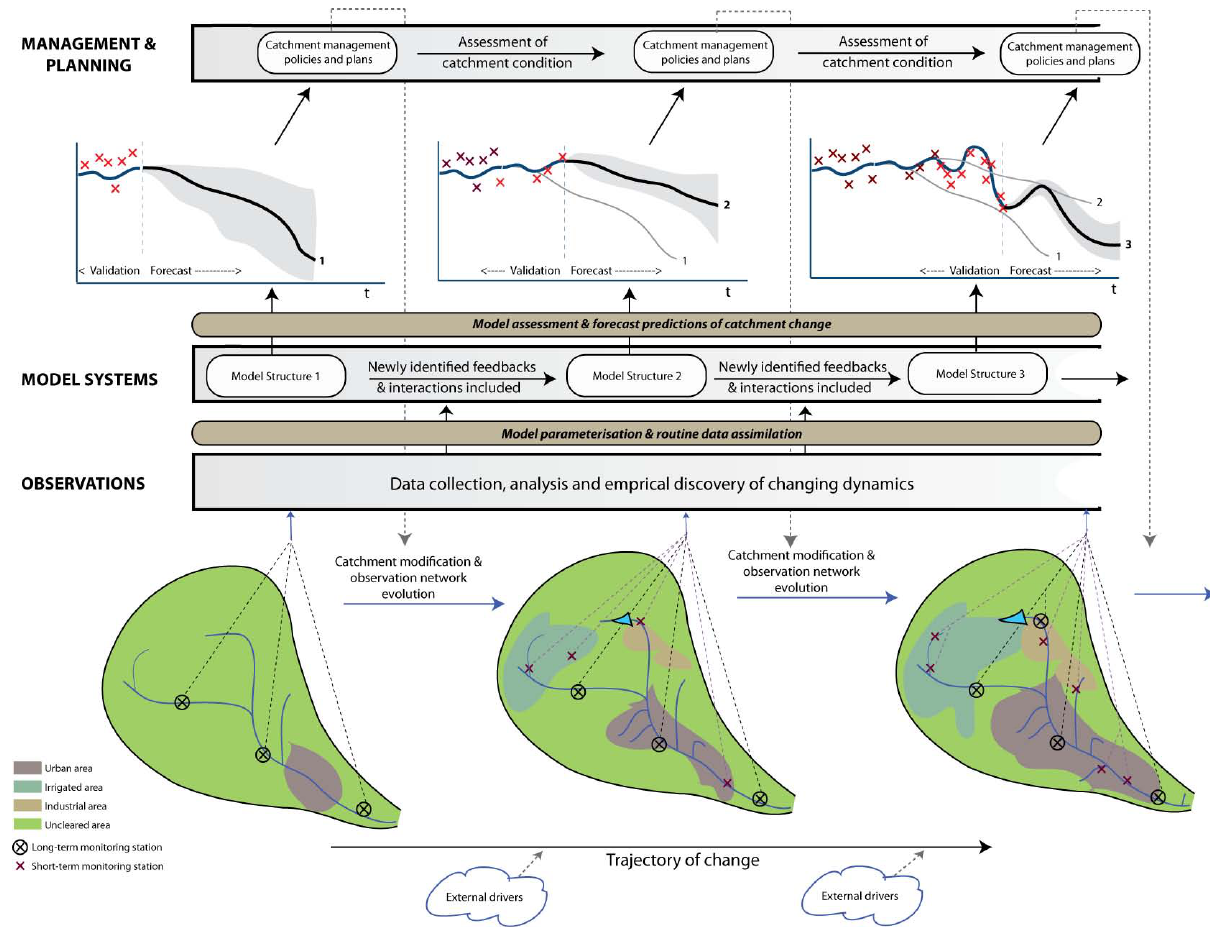
Fig. 6. Conceptual illustration of how model–data fusion could be built into a use-based science paradigm incorporating scientists, managers and the community for real-time management of water systems. The diagram highlights a system whereby (a) model uncertainty reduces over successive iterations of model development, (b) the model’s ability to reproduce new dynamics evolves as model structures improve, motivated by new learning from observations, and (c) the observation network adapts in response to changing land-use and management